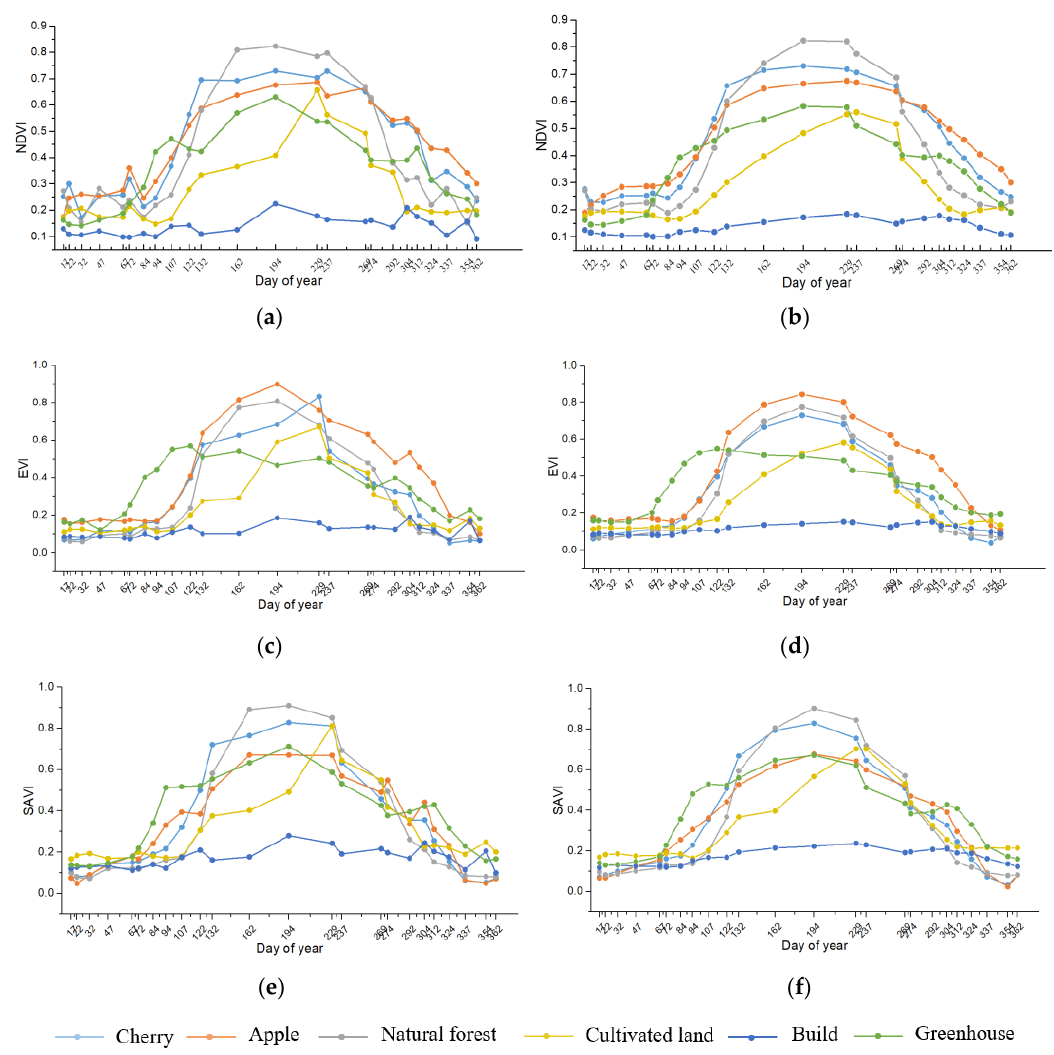
Figure 10. Vegetation index time-series before and after Savitzky – Golay ( S−G ) filtering. ( a , c , e ) Original vegetation index time-series curve; ( b , d , f ) Vegetation index time-series curve after S−G filtering.